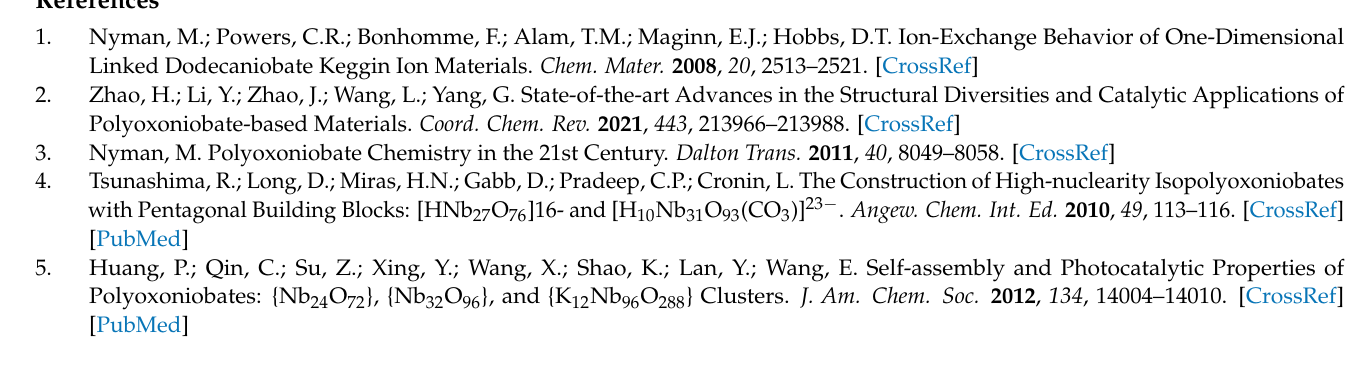
1 and 2 ; Figure S16: CV curves of 1 and 2 at different scan rates; Figure S17: The IR spectra of 1 after the recycle test; Figure S18: UV-vis spectra of postreaction solution, BA, benzyl aldehyde, and PNb 12 V 2 ; Figure S19: Proposed mechanism for the electrocatalytic selective oxidation of BA to benzaldehyde by 1